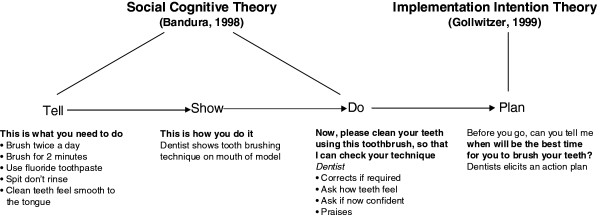
The OHA intervention behavioural framework.